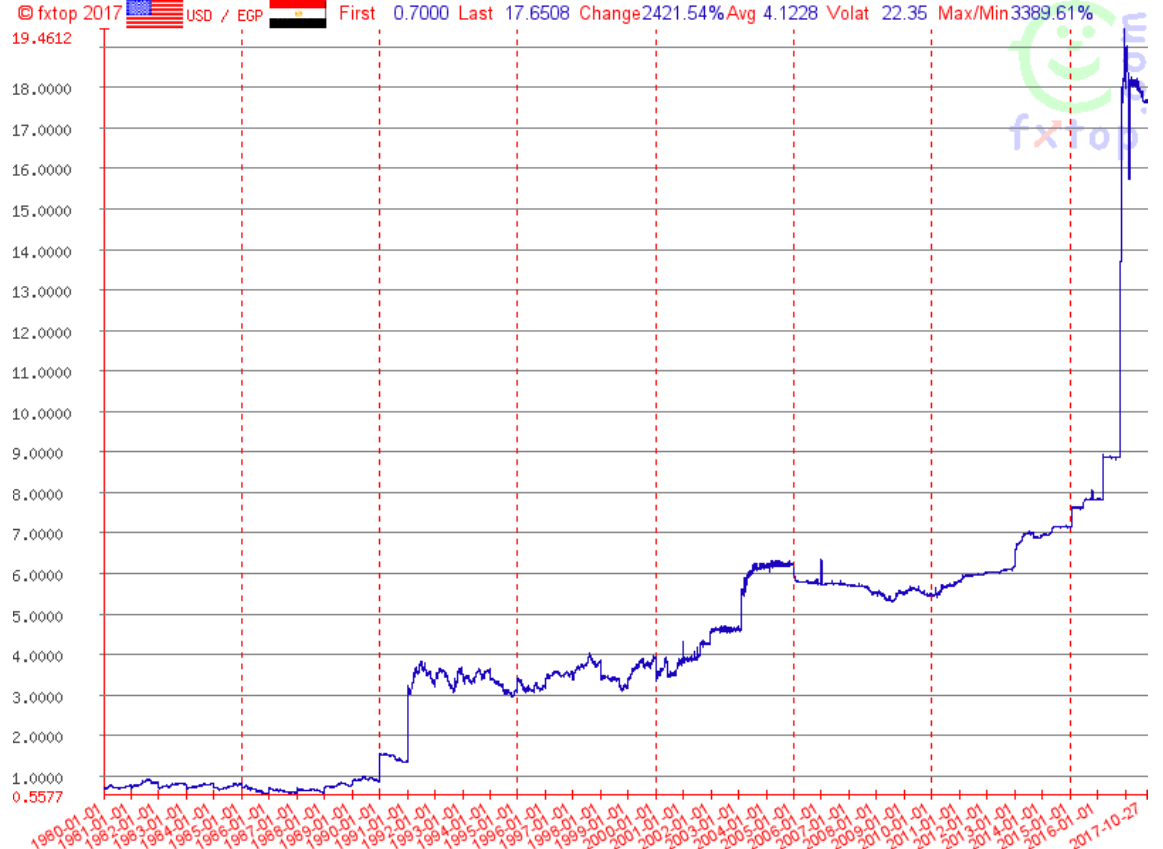
Figure 9. Historical exchange rates graph of USD vs. EGP 1